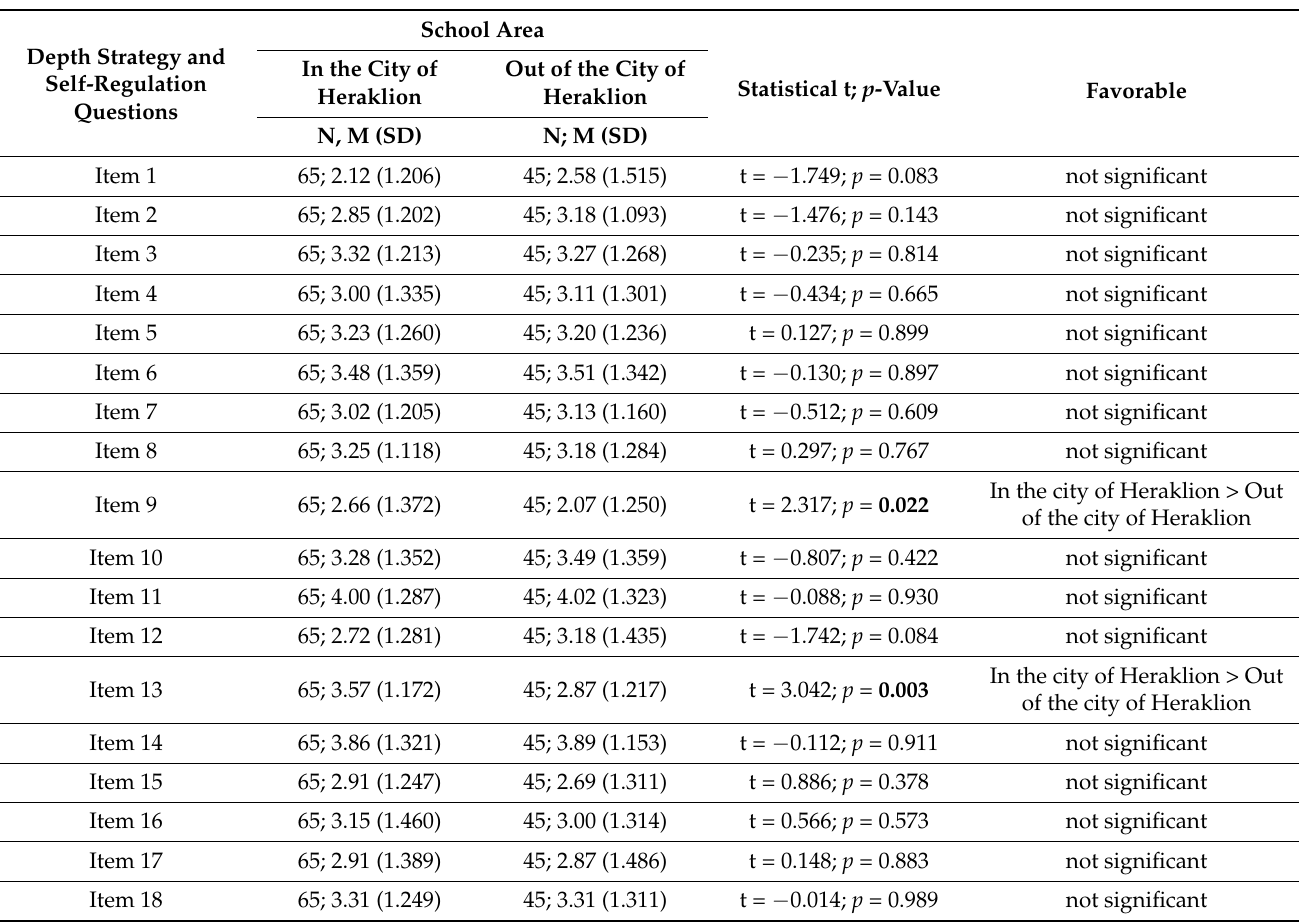
Table A1. Results of the Student’s t -tests according to school area.